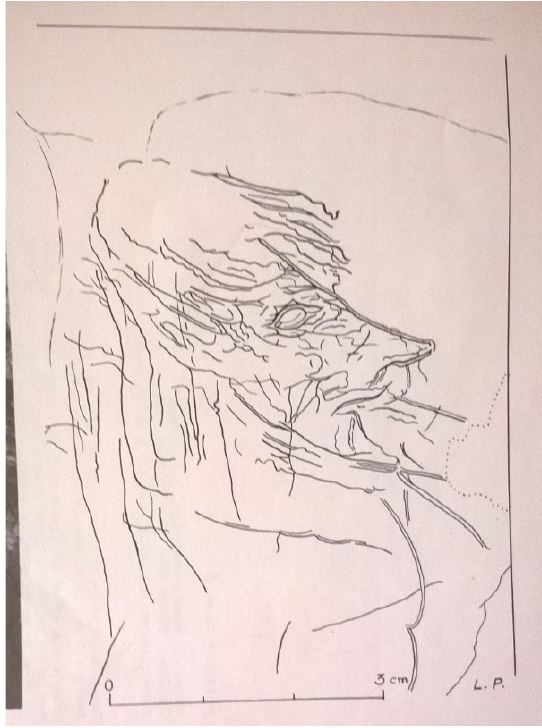
Figure 21. Group γ, example of Hand γ2: Obs. 7(II) (from Pales,